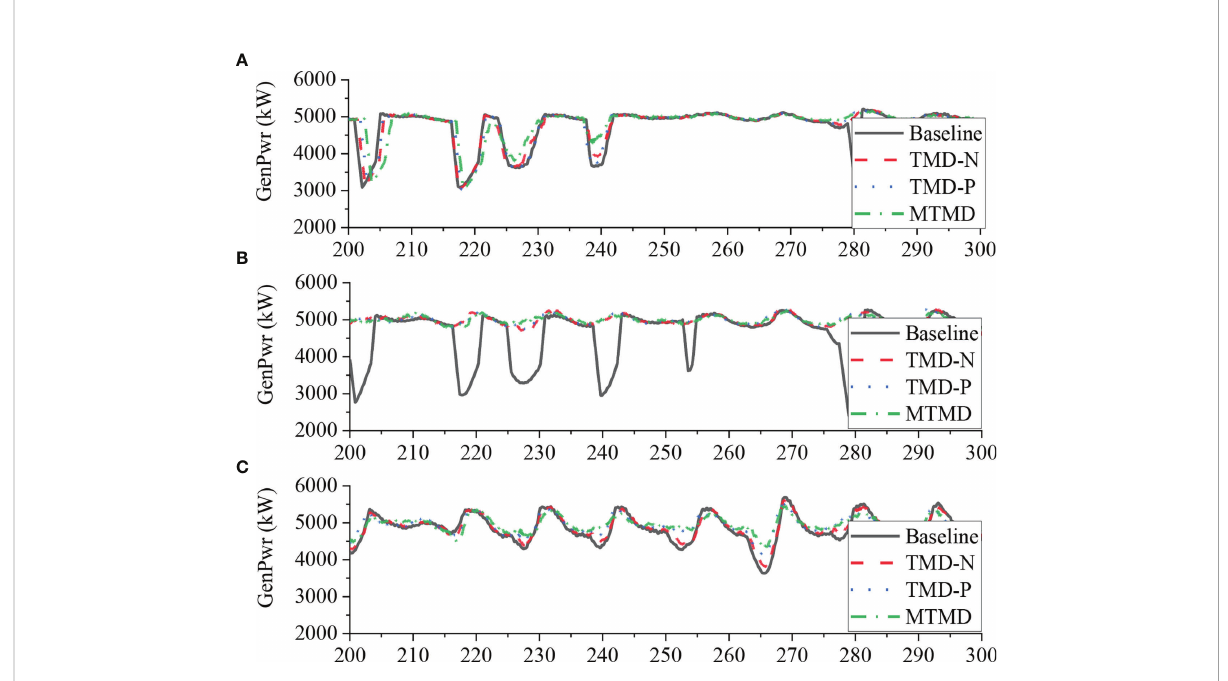
from the increased RMSs of the output power depicted in Figure 13. As depicted in the fi gure, the steady outputs under the majority of the selected load cases generally increase when using the deployed vibration control methods. For example, the RMS of the output under load case 4 is increased to 4952.91